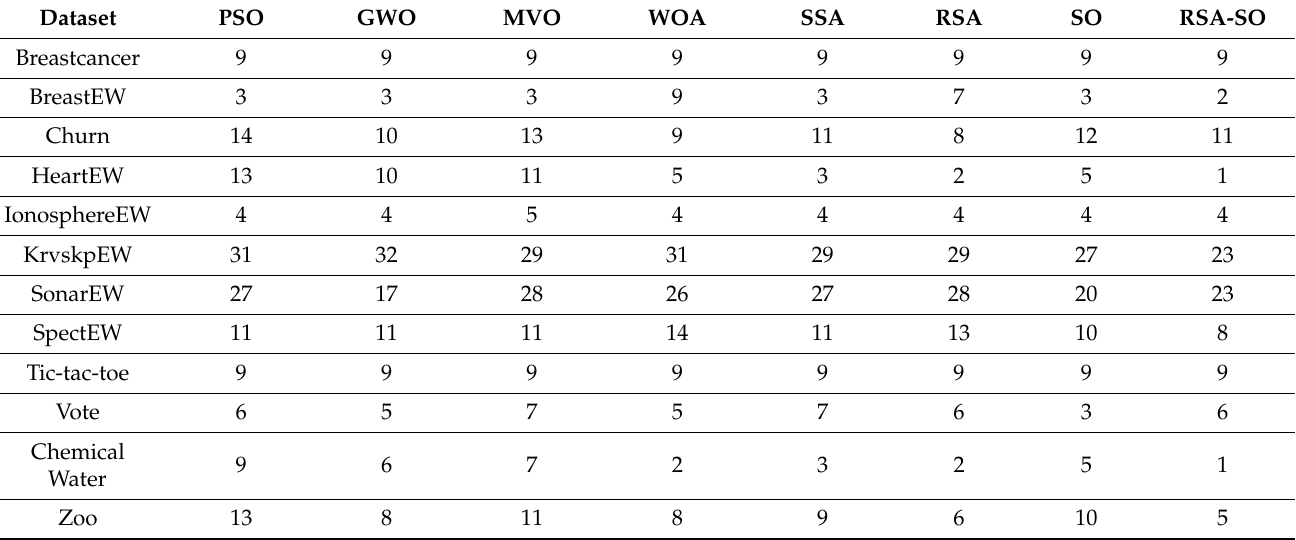
Table 4. Comparison between RSA-SO and other methods in terms of average